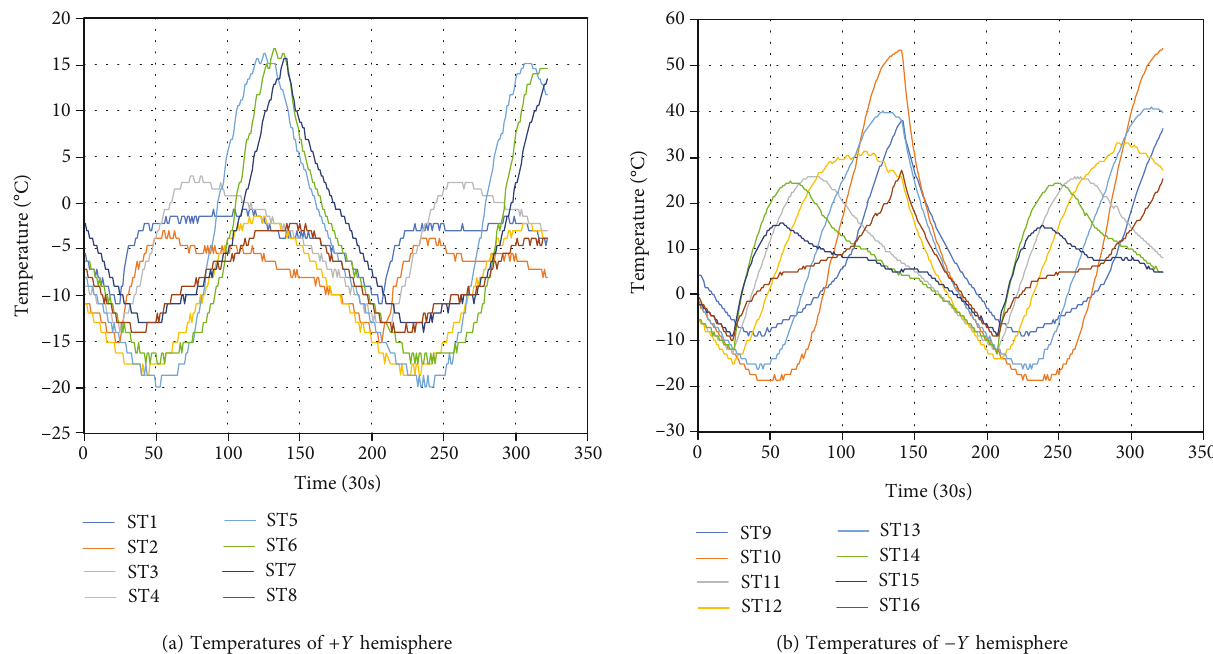
Figure 15: Temperatures of hemispheres on orbit on 2021.2.10 ( X : time (30 s); Y : temperature ( ° C); ST N : surface temperature of N # panel in Figure